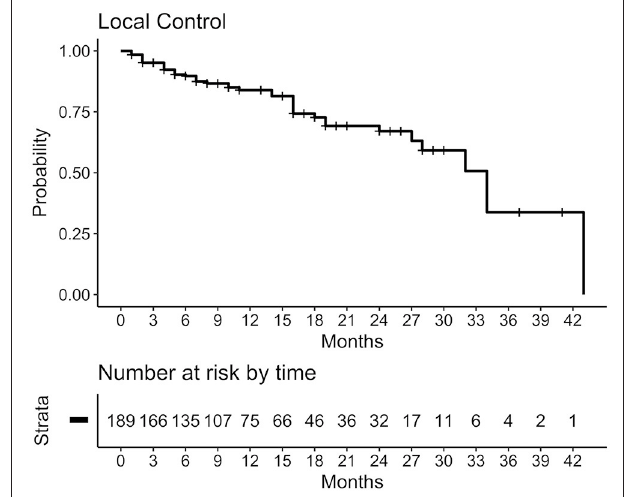
FIGURE 2 | Kaplan-Meier-Plot for local control. For 189 lesions (with at least one follow-up with cMRI) a 1-year local control rate of 84% was observed, calculated from time of corresponding course to date of the event. Censored in case no event occurred or if WBRT had to be administered.